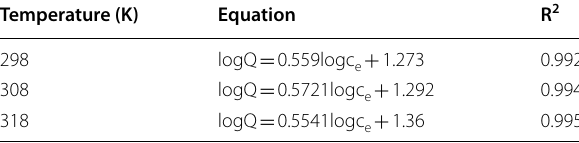
Table 3 Freundlich model fitting results of